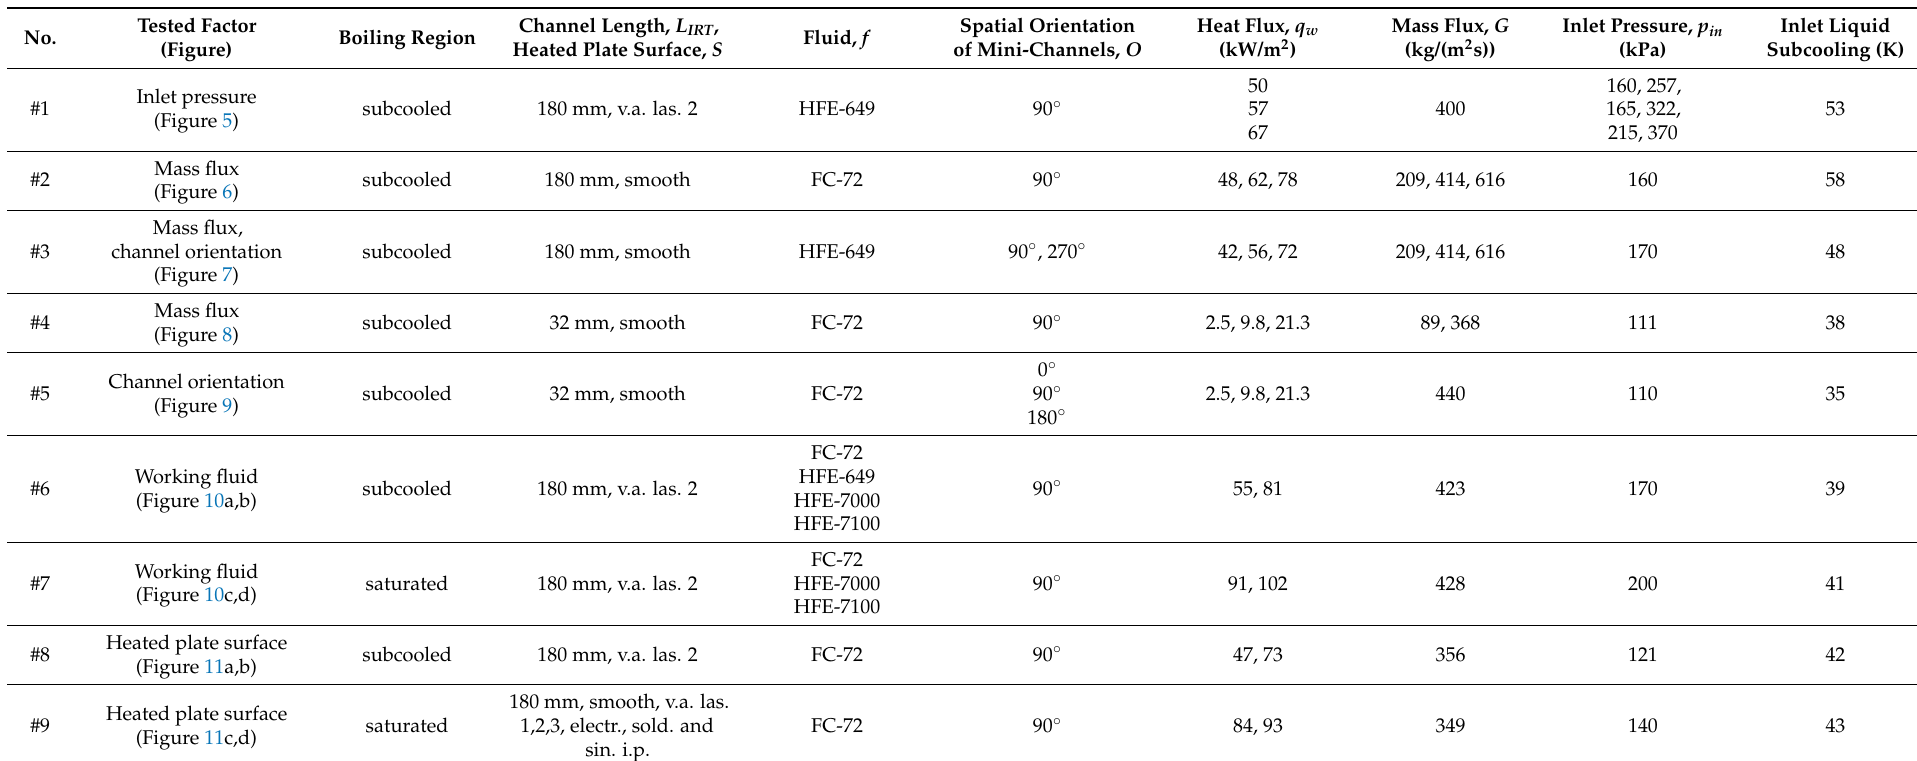
Table 5. The database of research on the influence of selected factors on flow boiling in